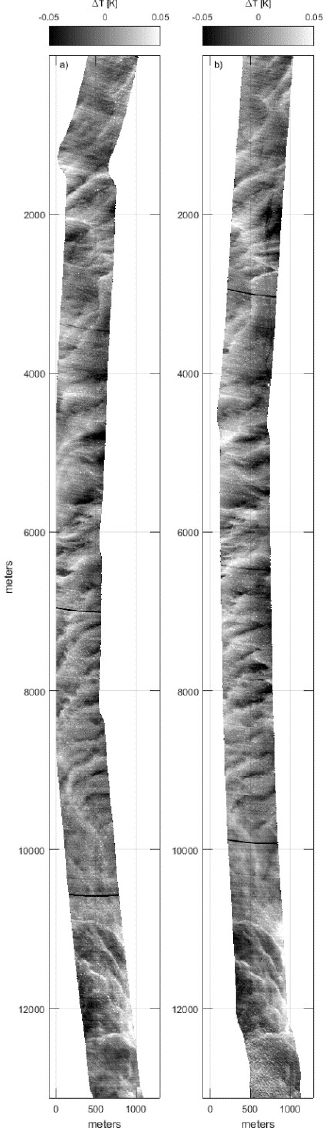
Figure 14. Two consecutive infrared swaths (9 min apart) over nearly the same patch of the ocean surface, taken on 4 November 2015 simultaneously with dye visualization (see raw image in Figure 7). The signal’s noise is suppressed by averaging over 10 frames for each pixel and by band pass filtering between 10 and 500 m.